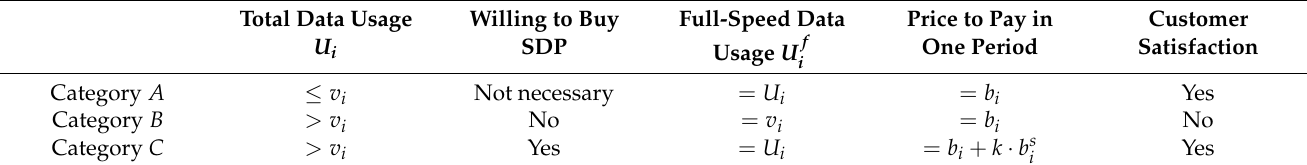
Table 2. Three categories of subscribed